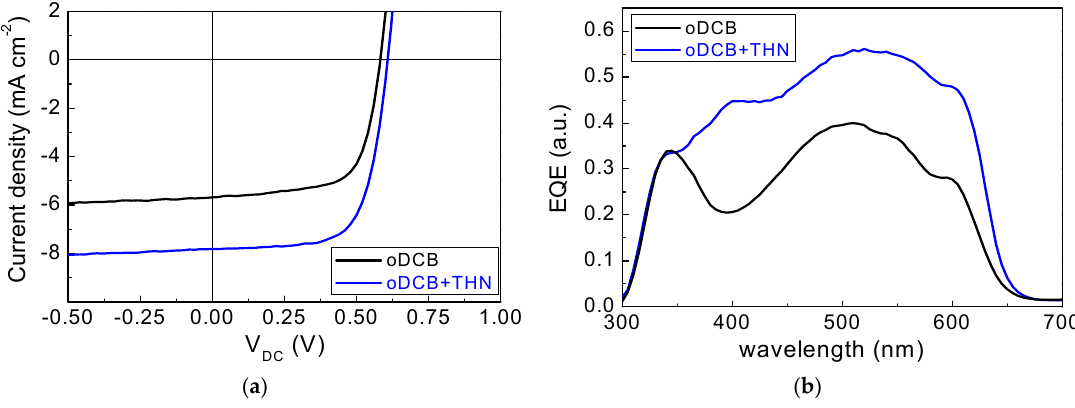
Figure 1. ( a ) Illuminated current density-voltage characteristics of solar cells with active layers prepared using the solvents oDCB (black line) and oDCB+THN (blue line); ( b ) External quantum efficiency (EQE) characteristics of solar cells with blends using the solvents oDCB (black line) and oDCB+THN (blue line).